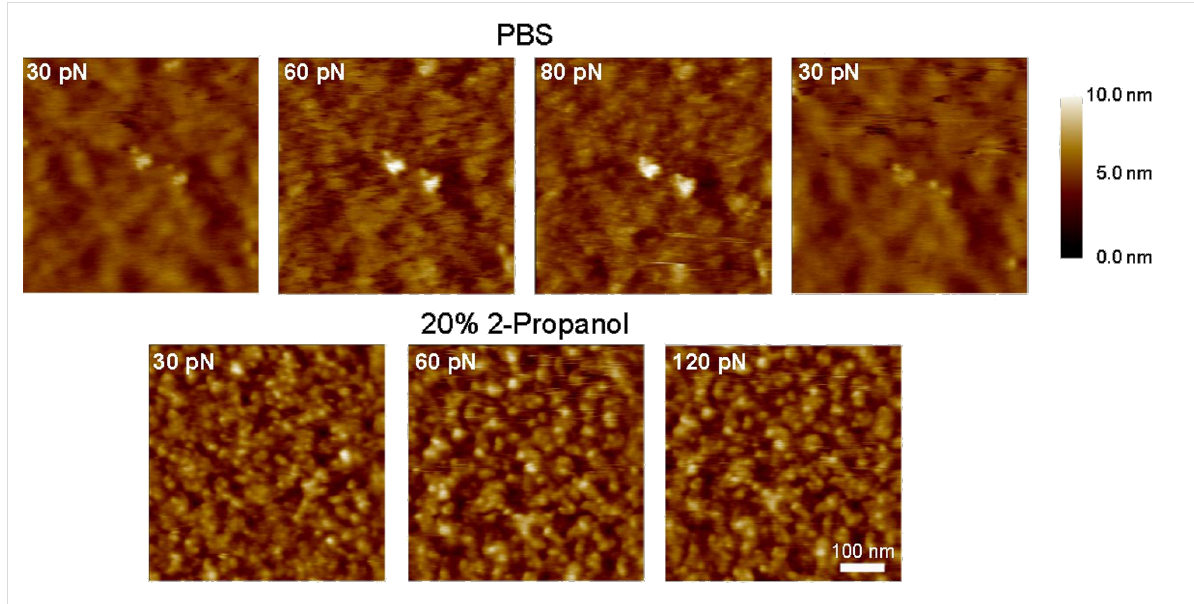
Figure 6: AFM images of Au-tethered PEG-layers obtained at different forces in good solvent (PBS; upper row) and in poor solvent (20% 2-propanol in PBS; lower row) conditions. Images in PBS show an improved resolution of the underlying Au surface (on the same area) as the force set point is increased from 30 → 60 → 80 pN indicating penetration/splaying of the PEG layer by the tip. The Au surface is covered again after the force set point is reduced back to 30 pN. The lower series of images were acquired in 20% 2-propanol and do not show any dependence on the force applied. This effect was similar over different areas on the sample (the 30 pN area is different from the 60 and 120 pN area), and implies that the tethered chains have collapsed under poor solvent conditions. All images were obtained on the same microcantilever array chip. The scale bar is 100